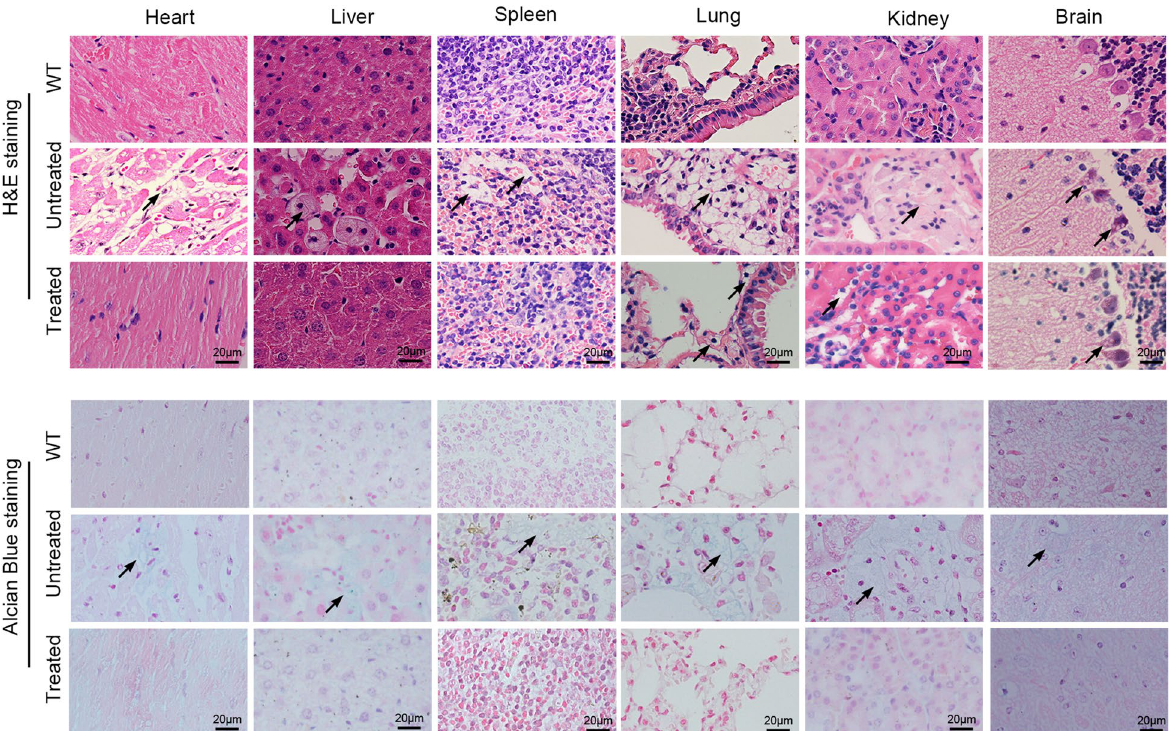
Fig. 5 In vivo base editing corrects histological abnormalities in MPS IH mice. (Top) Histological analysis of the heart, liver, spleen, lung, kidney and brain tissues at 32 weeks post-injection by hematoxylin and eosin stain. Scale bar, 20 μm. Black arrows indicate foamy macrophages in the tissue due to GAGs accumulation. (Bottom) The tissues were stained with Alcian blue to detect GAGs. Scale bar, 20 μm. Black arrows indicate the GAGs storage in the